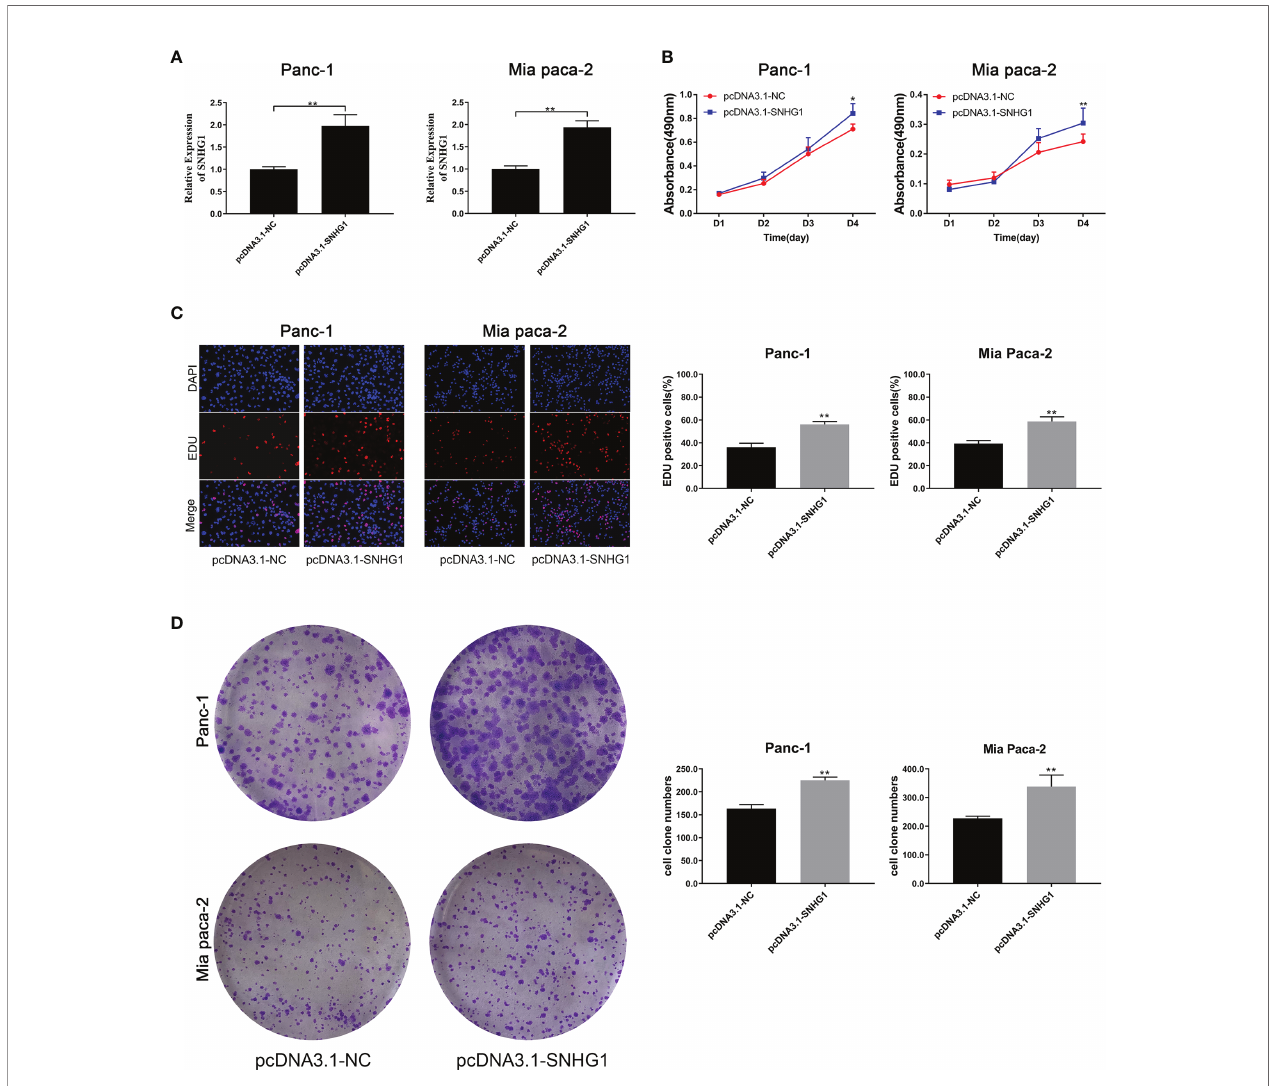
FIGURE 3 | Upregulation of SNHG1 enhances PC cell proliferation and viability. (A) qRT-PCR quanti fi cation of SNHG1 overexpression. (B) Cell viability was measured by the MTT assay. (C, D) Cell proliferation was showed by EDU assay and colony formation assay. *p < 0.05, **p <